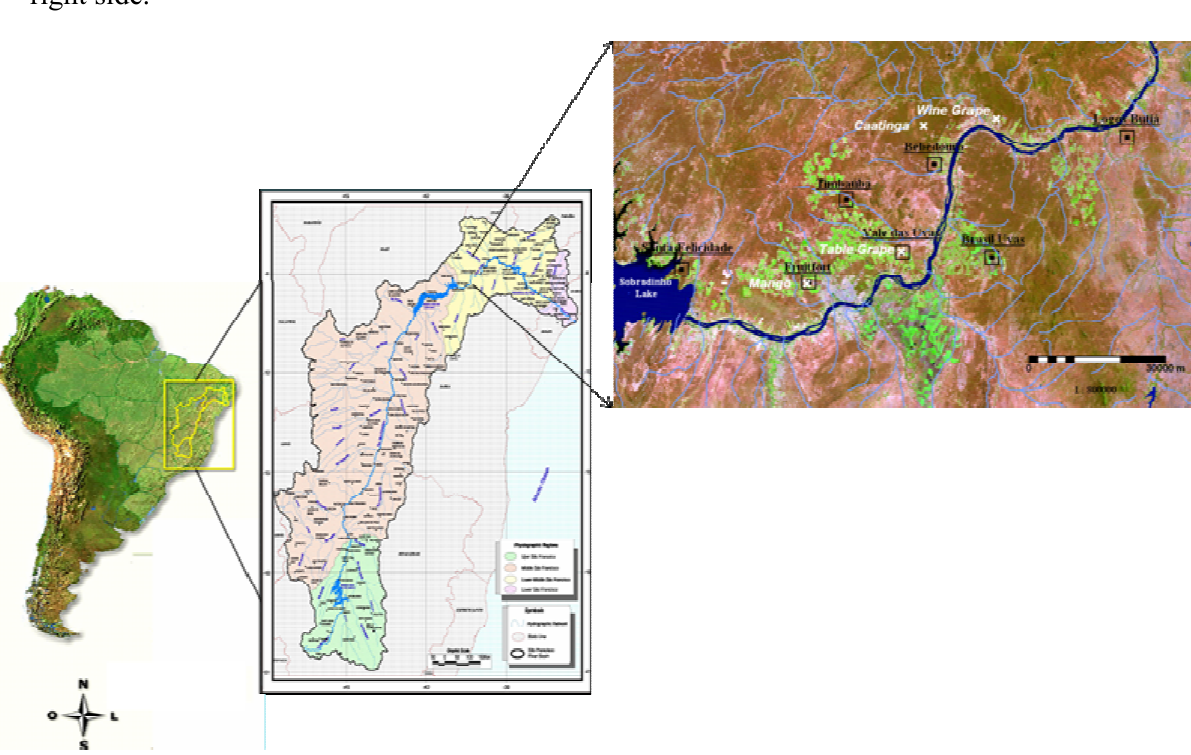
Figure 4. The São Francisco river basin and the semi-arid region studied. The agro- meteorological stations (black) and the flux towers (white) on irrigated fruit crops (wine grape, table grape, mango orchard) and natural vegetation (caatinga) are indicated on the right side.